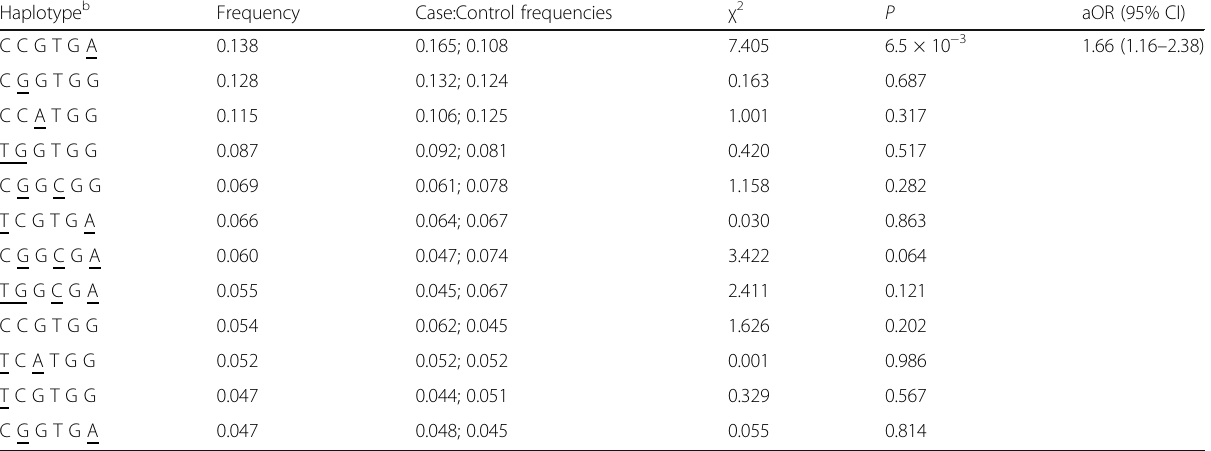
Table 5 Haplotype frequencies across 7 SHBG SNPs analyzed a Haplotype